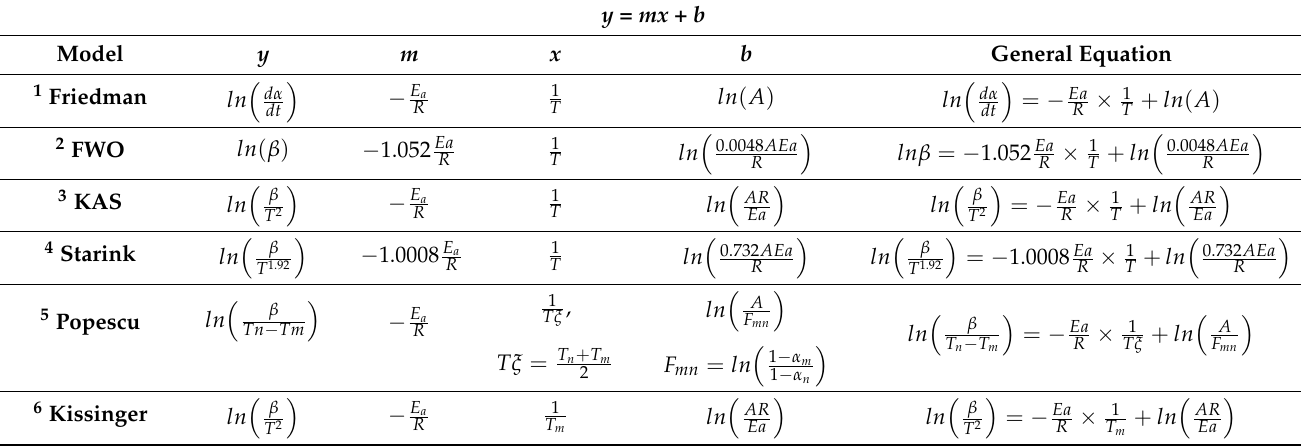
Table 1. Mathematical models for the determination of kinetic parameters. [30]. y = mx + b